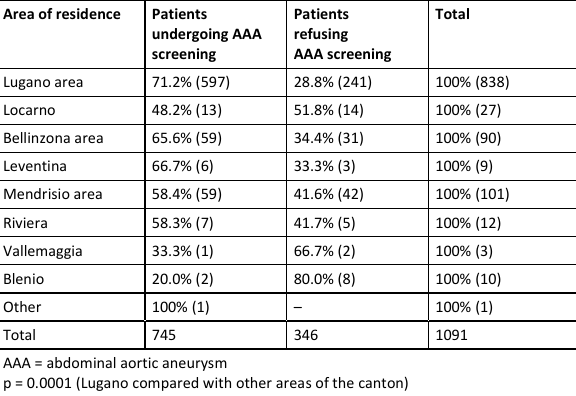
Table 2: Abdominal aortic aneurysm screening acceptance rate by area of residence (eligible